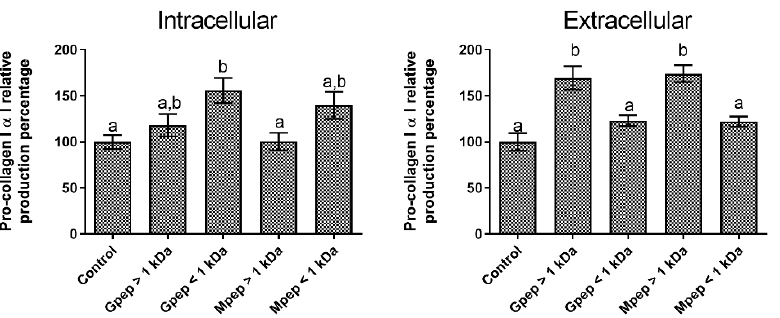
Figure 4. Pro-collagen I α I relative percentage of production in the presence of different peptide fractions relative to the basal level (control) in HDFa cells. Different letters represent the statistically significant differences ( p < 0.05) found between the samples tested in each